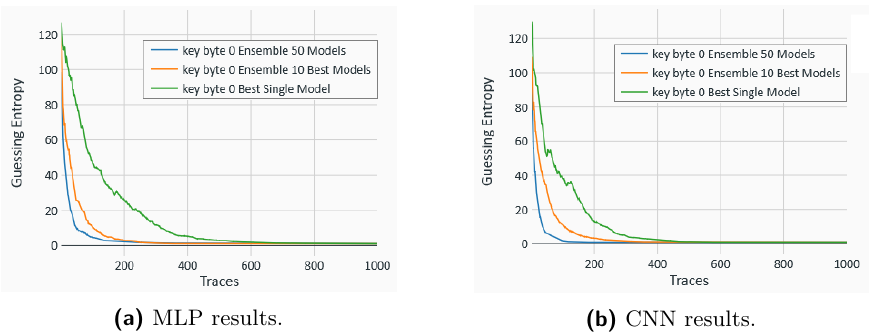
Figure 14: Guessing entropy for CHES CTF 2018 for the Hamming weight leakage model.